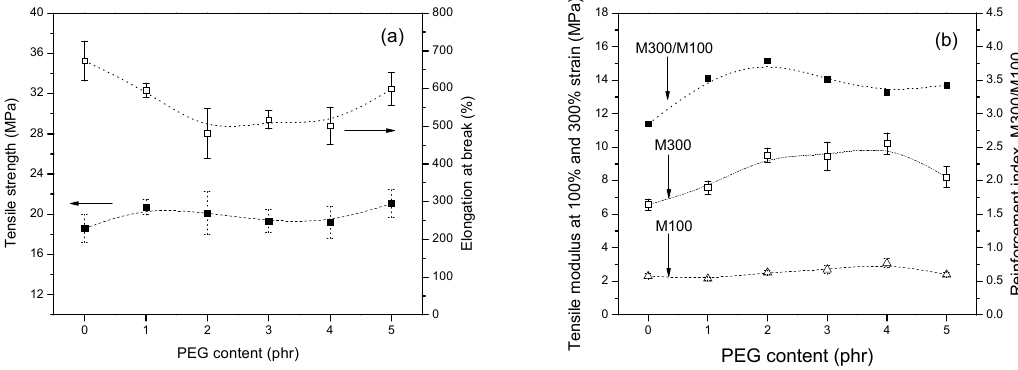
Figure 9. Effect of PEG contents on ( a ) tensile strength and elongation at break and ( b ) 100%, 300% modulus and reinforcement index (M300/M100) of silica/silane compounds.